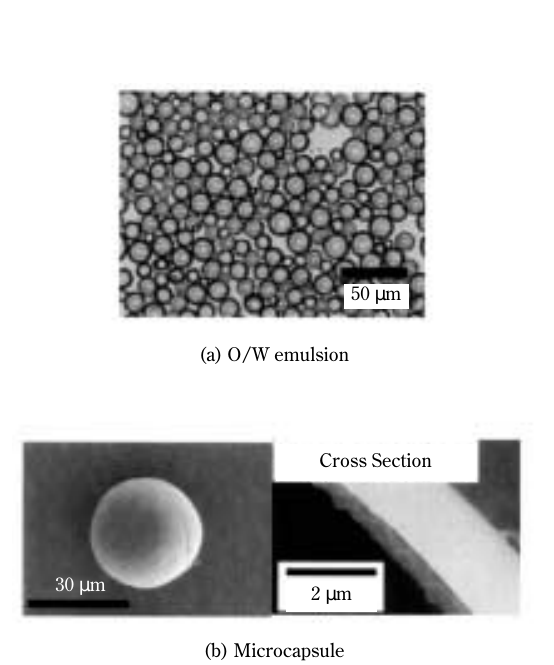
Fig. 10 Photographs of O/W emulsion and microcapsules pre- pared by phase-inversion emulsification and the subse- quent